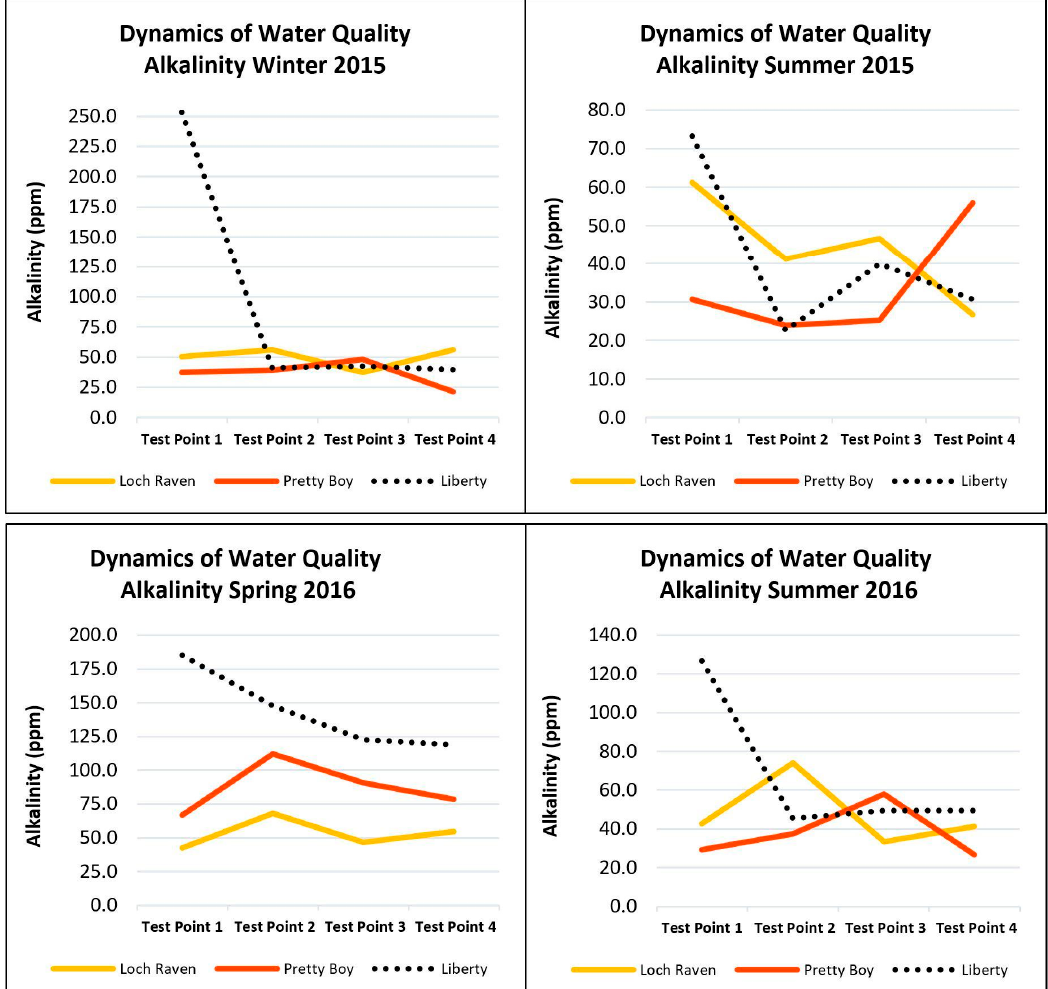
Figure 7. Dynamics of alkalinity levels in Liberty, Loch Raven and Prettyboy watersheds during 2015–2016. Figure